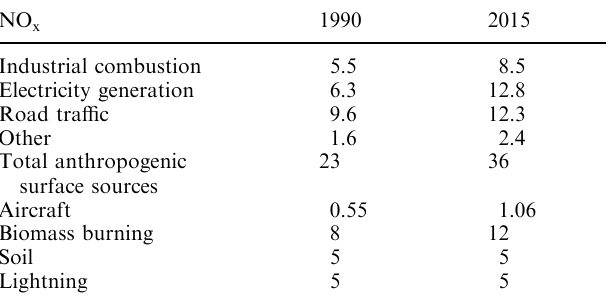
Table 1. Global NO emissions for 1990 and 2015 based on the x EDGAR inventory and the IMAGE Baseline A scenario (for the surface sources), and the ANCAT-2 emission inventory for 1991/ 1992 and the ANCAT projection for 2015 (for the aircraft emis- sions). The emissions from natural sources (Mu¨ ller, 1992, 1993) are assumed to be constant over time. The values are in Tg N y )